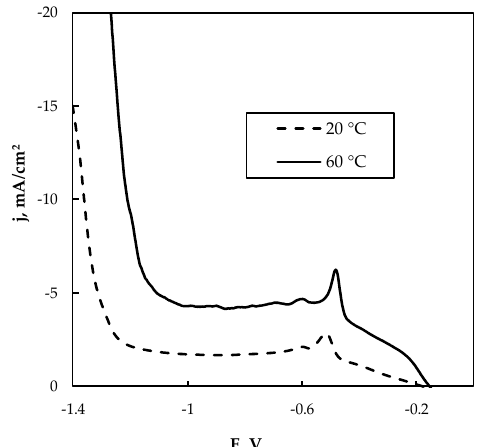
Figure 8. Cathodic polarization curve on Cu electrode at 20 °C and 60 °C from the leachate “L2”; potential scan rate 5 mV/s, pH 6.5.